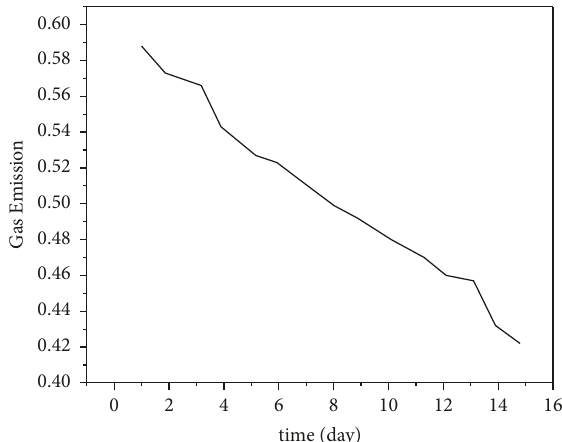
Figure 5: Attenuation curve of gas emission from the test borehole (1m from the blasting hole).